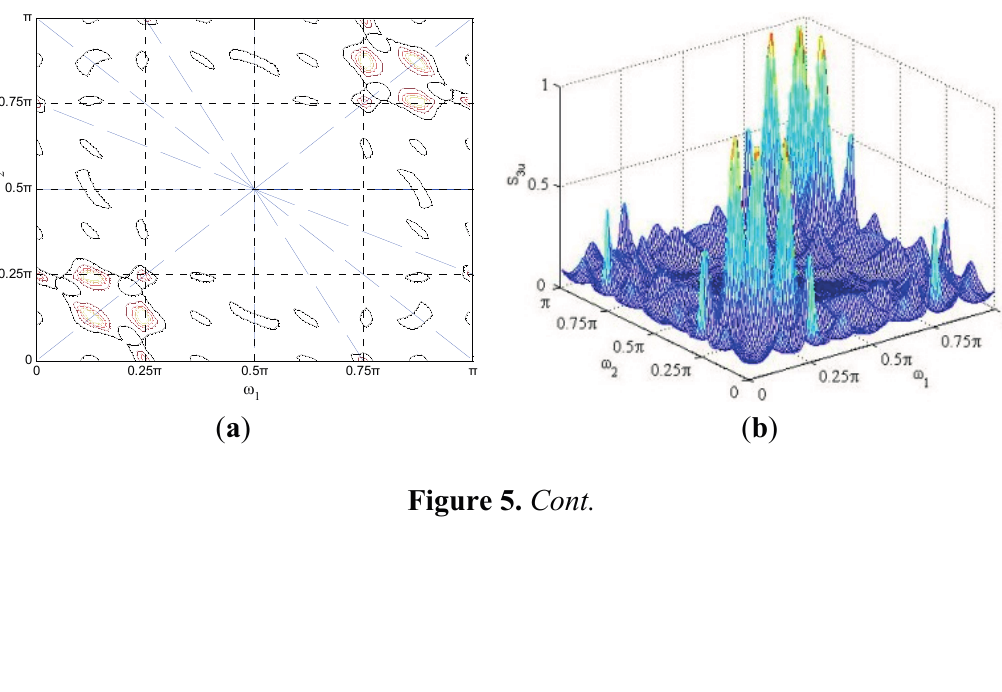
Figure 4. AR bispectra of halogen lamp. ( a ) Normal contour; ( b ) Normal amplitude; ( c ) Normal phase angle; ( d ) Normal 1½ - D slices; ( e ) Arc fault contour; ( f ) Arc fault amplitude; ( g ) Arc fault phase angle; ( h ) Arc fault 1½-D slices.